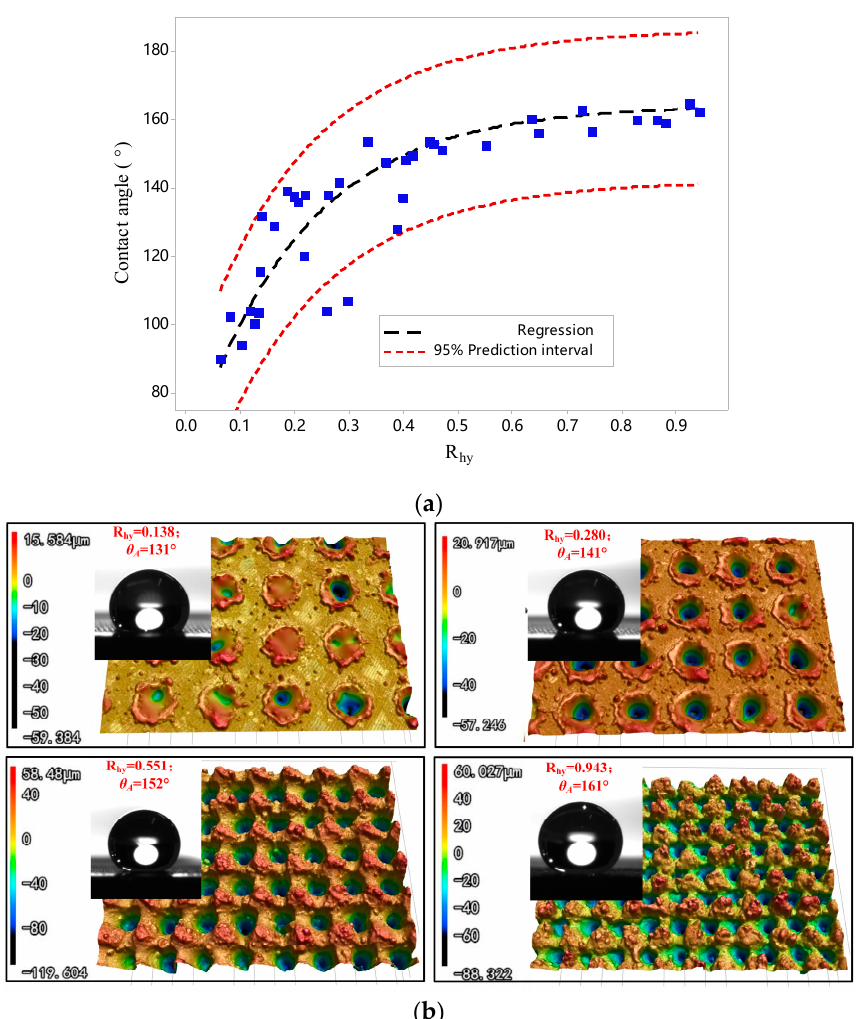
Figure 6. ( a ) Fitted line by exponential function between R hy and contact angle; ( b ) Surface morphology and shape of water drops on specimens with a different value of R hy .